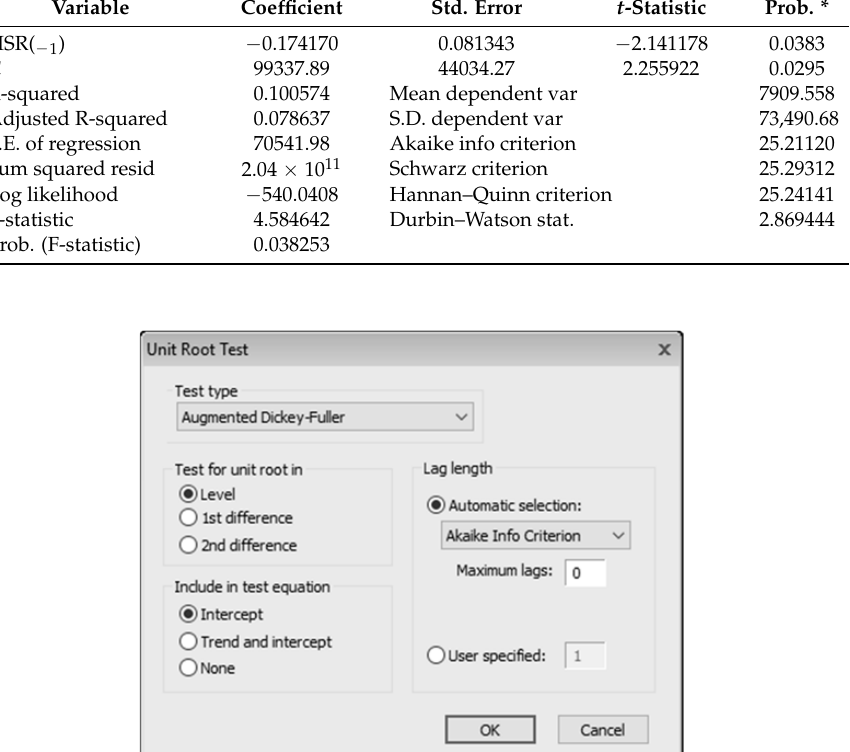
Table 2. ADF test equation.